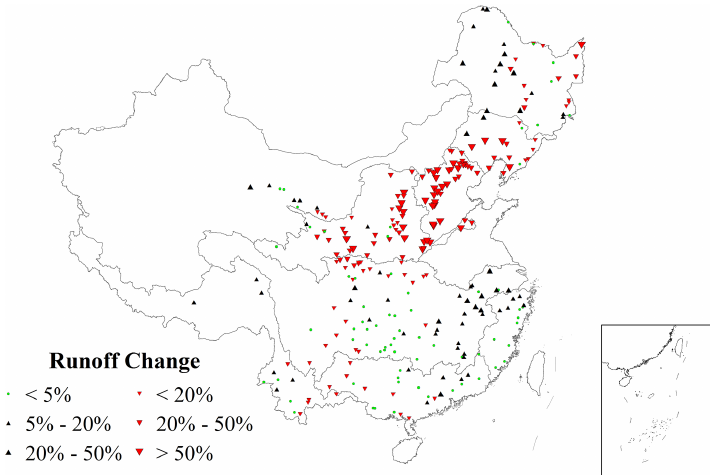
Figure 5. Mean annual runoff change rate between two periods.